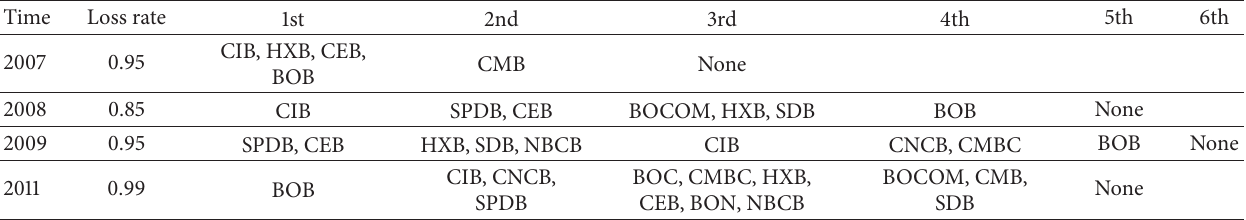
Table 3: ICBC as the source of risk contagion.